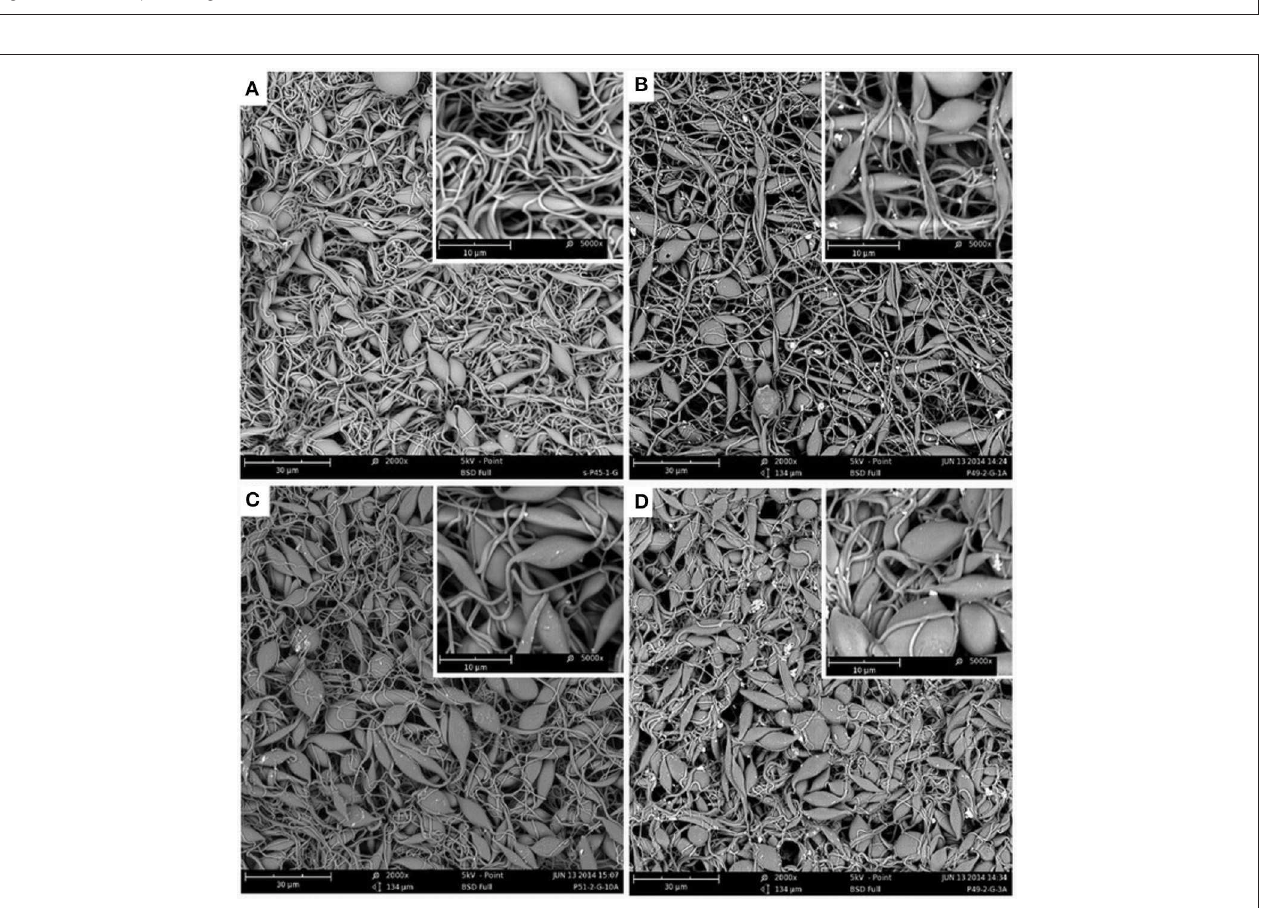
FIGURE 3 | SEM images of 300% poly(GMA)-grafted nanofibers (A) and nanofibers aminated with DEA with DA of 30% (B) , 85% (C) , and 93% (D) with magnification of 2,000 and 5,000 (inset). fiber diameter increased from 500 nm for a grafted sample to 608, 644, and 742 nm for 22, 50, and 82% DA,